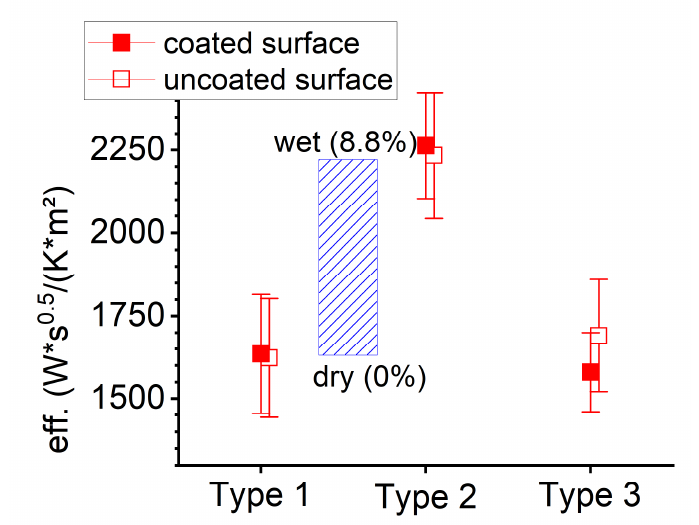
Figure 13. Measured effusivities with their uncertainties (same data as in Figure 12) in relation to the estimated effect size of moisture influence, as indicated by the blue striped rectangle (expected dynamic range).